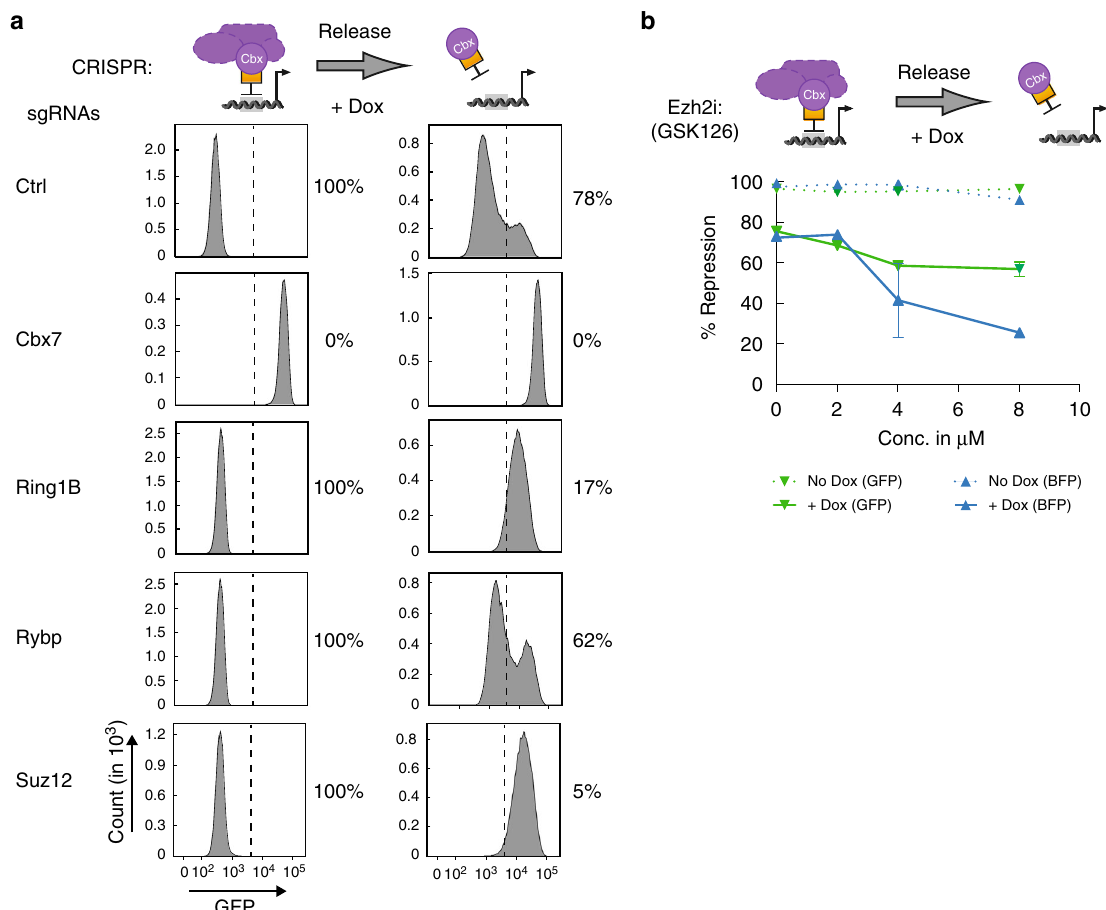
Fig. 3 cPRC1 and H3K27me3 are required for maintenance of reporter gene silencing. a Flow cytometry histograms before and after 6 days of Dox treatment of CRISPR mutant clones isolated from sgRNA-treated cPRC1-mESCs. Percentage indicates fraction of GFP-negative reporter cells. b Percentage of GFP- and BFP-negative cells before and after 6 days of Dox treatment in response to increasing concentrations of Ezh2 inhibition by GSK126. Data are mean ± SD (error bars) of two independent